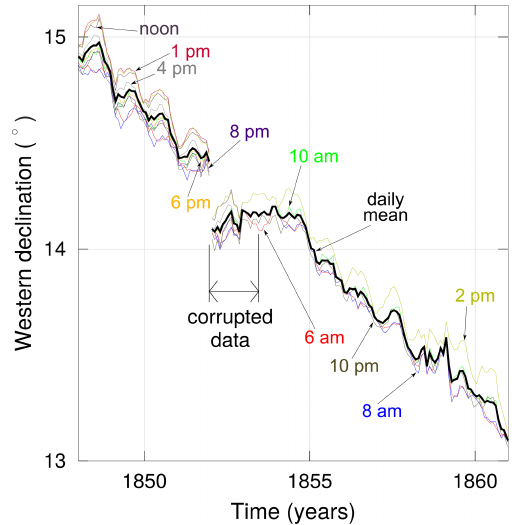
Figure 1. Time series of western declination according to observa- tions at the Clementinum observatory in Prague for the period from the beginning of 1848 to the end of 1860. The values measured at different times of the days are plotted in different colours. The times when the measurements were taken is assigned to the indi- vidual lines. The average daily values are shown by a thicker black curve. The period with unreliable data in variations of declination (which we discuss in Sect. 3) is pointed